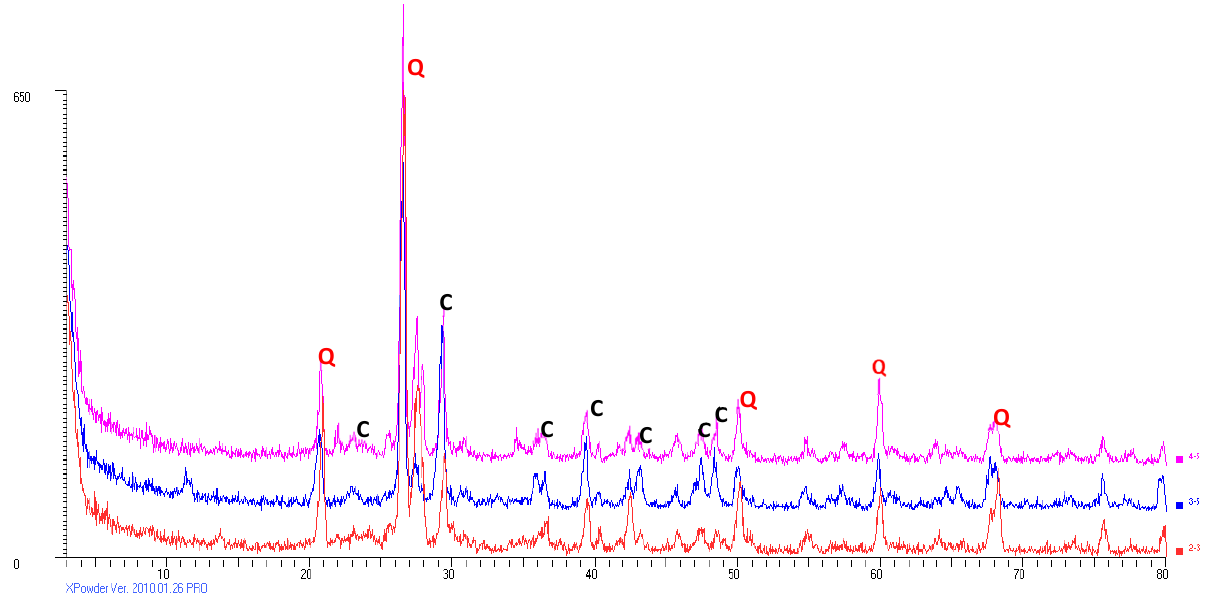
Figure 2. XR diffractogram of three samples of street dust. Q: quartz; C: calcite.